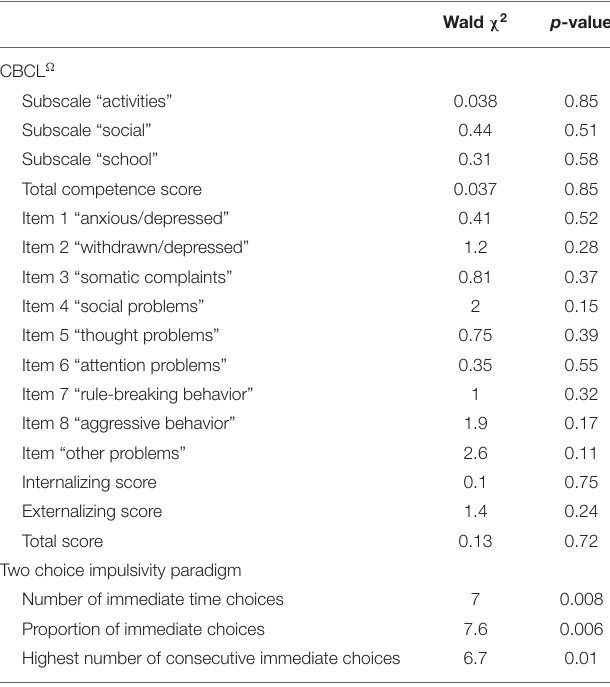
TABLE 3 | Group × time interaction effects for clinical variables measured with a generalized estimating equations